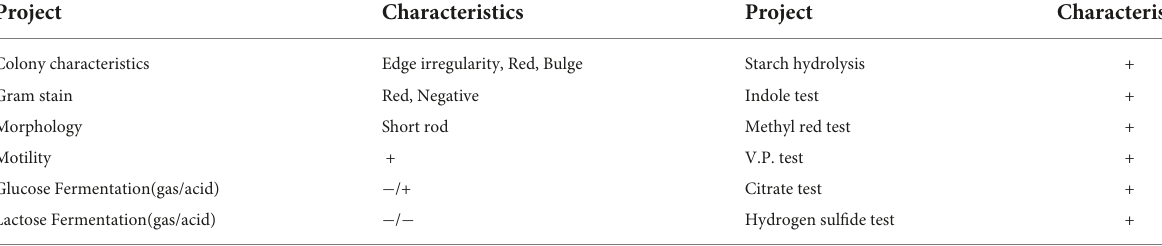
TABLE 1 Morphological physiological and biochemical characteristics of strain X-45.